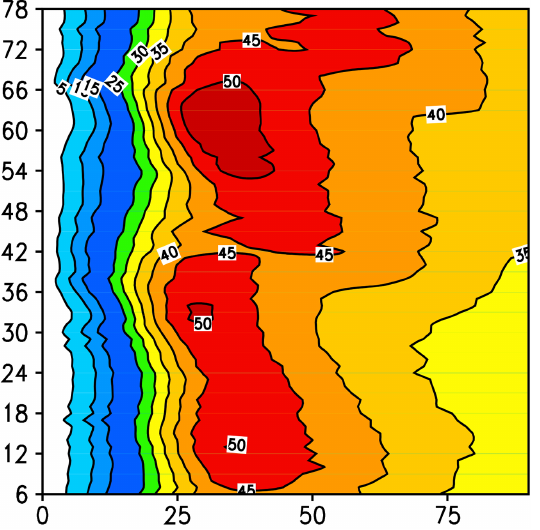
Figure 4. Evolution of the simulated azimuthal mean component (ms − 1 ) of the 700hPa wind in the 9km domain. The x axis and y axis indicate the distance (km) from the storm center and the in- tegration time (hours),